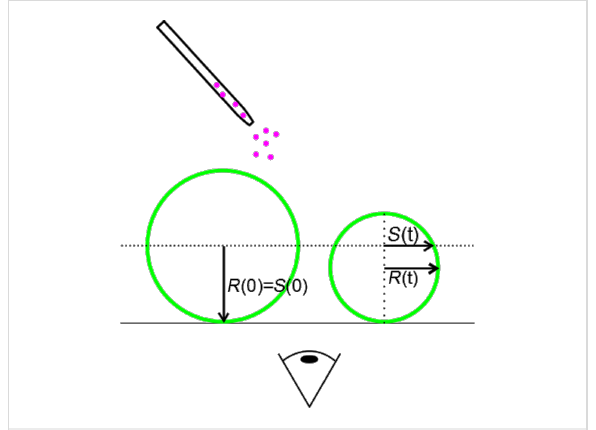
Figure 9: Nanoparticles are added to the medium. After equilibration a vesicle is observed at constant focal height. The evolution of the vesicle size is monitored by means of the observed cross section area S ( t